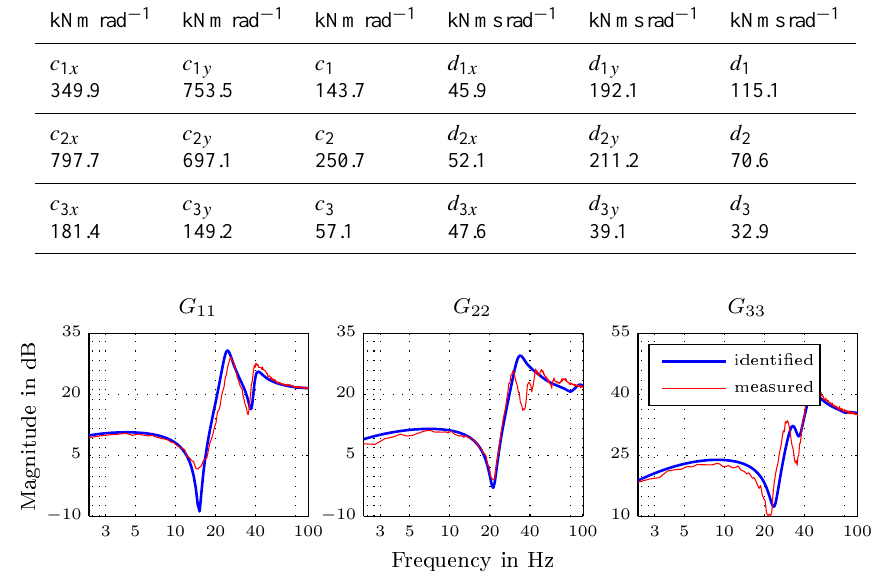
Figure 9. Comparison of the measured non-parametric FRM ˆ G [ qP 3 ] and the identified parametric one G [ qP 3 ]